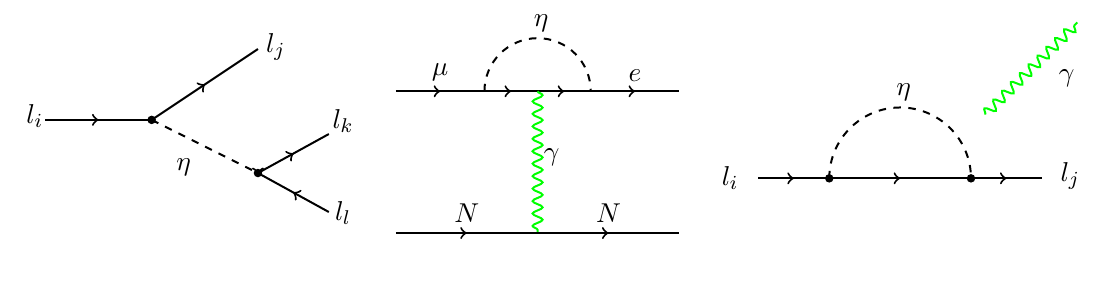
Figure 2 . The l i ! l j l k l l (left), (cid:22) $ e -conversion (center) and l i ! l j (cid:13) (right) processes mediated by the lightest scalar, (cid:17) . In the diagram on the right, the photon can be attached to the internal fermion propagator, or to the external fermion